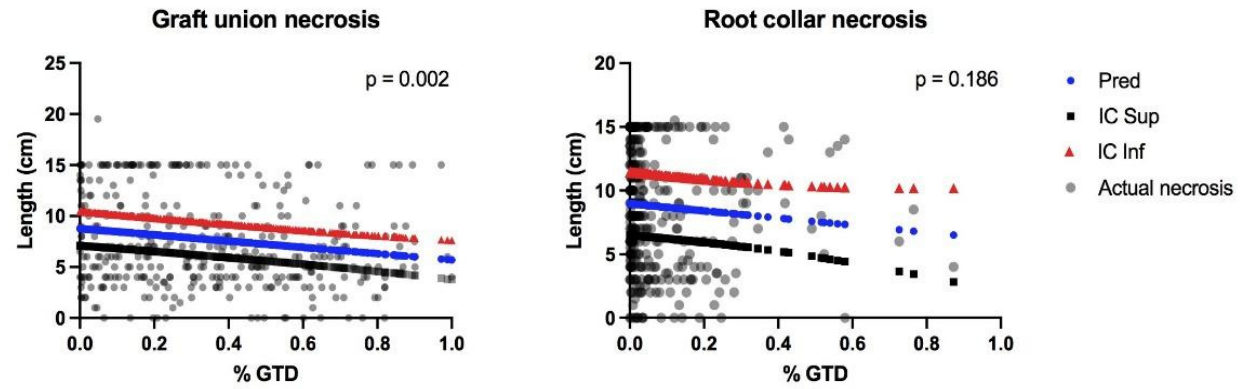
Figure 5. The correlation of GTD-related fungi (% GTD) to the length of necrosis (cm) in each plant tissue. Predicted (Pred) necrosis with confidence intervals (IC Sup and IC Inf) is compared with the observed (actual) necrosis.